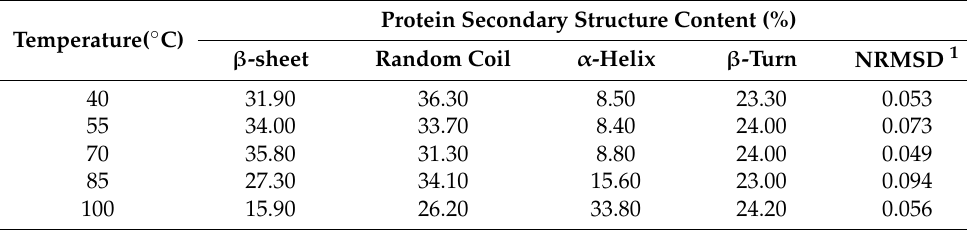
Figure 5. CD spectra of soluble EBN protein. Table 1. Effect of temperature on secondary structure of soluble EBN protein.